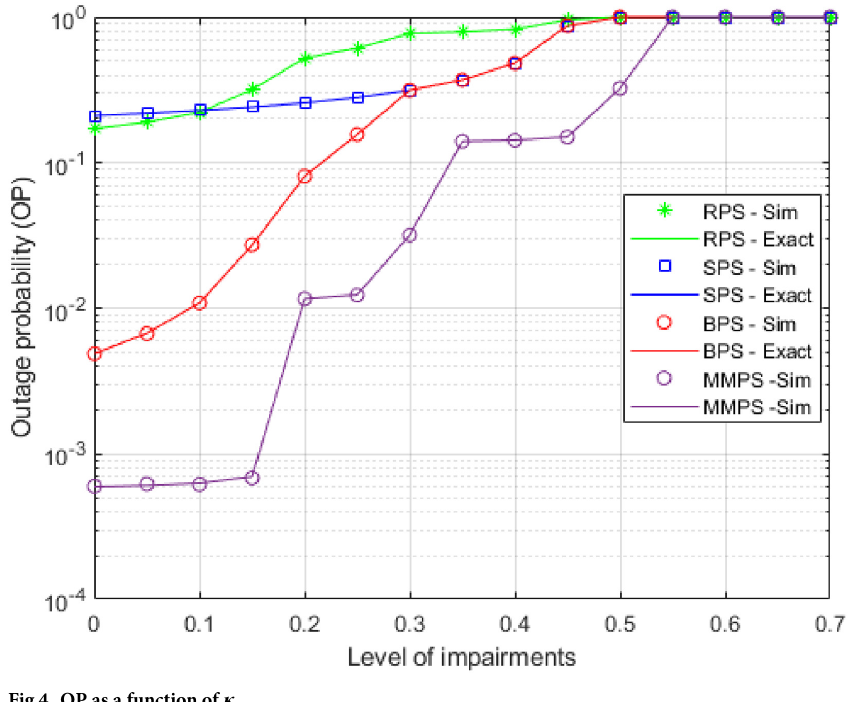
Fig 4. OP as a function of κ